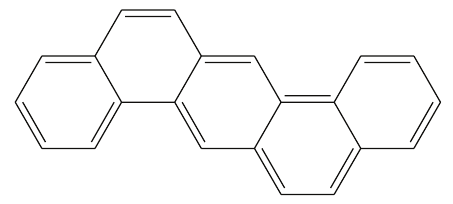
Figure 1: 1,2: 3,4-dibenzanthracene.